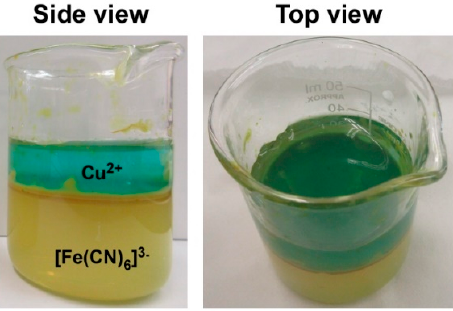
Figure 5. Side and top views of a beaker in which an agarose gel containing Cu 2+ ions was placed atop an agarose gel containing [Fe(CN) 6 ] 3 − ions at 25 °C for 300 s. The initial conditions of these gels are as follows. The Cu 2+ gel: [Cu 2+ ] = 0.200 M and 1.0 mass% agarose. The [Fe(CN) 6 ] 3 − gel: [[Fe(CN) 6 ] 3 − ] = 0.040 M and 1.5 mass% agarose. When seen from above, the blue Cu 2+ gel appears